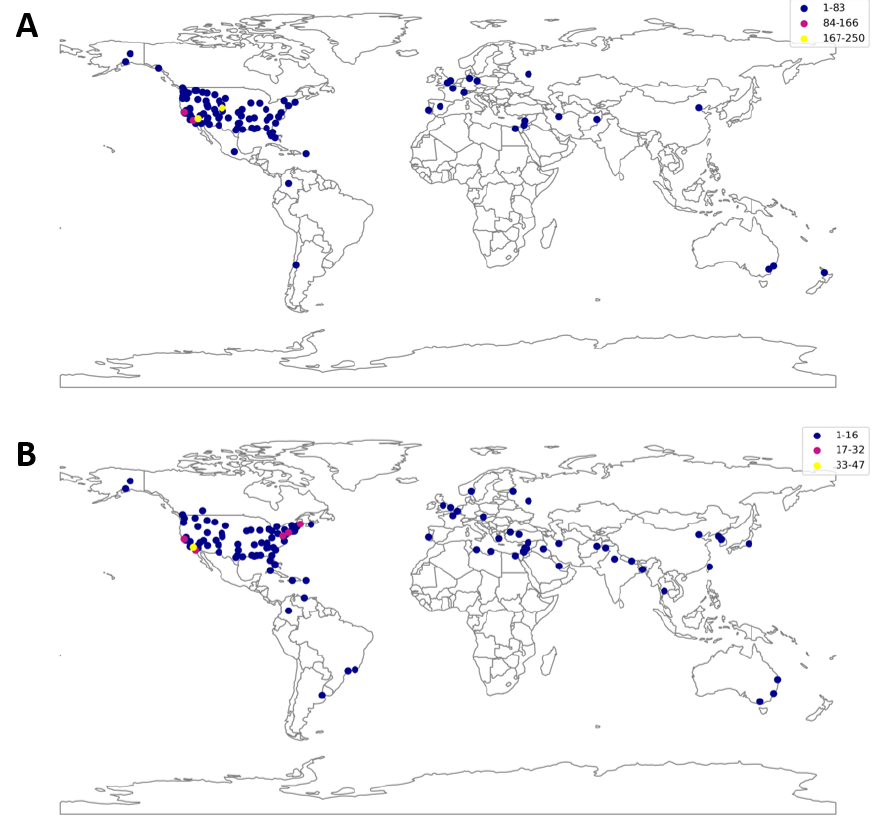
Figure A6. Cities discussed in wildfire articles within Western ( A ) and Northeastern ( B ) Newspapers. Coverage in western newspapers is mostly concentrated in the west, while coverage in northeastern newspapers spans more across the U.S. and the globe.